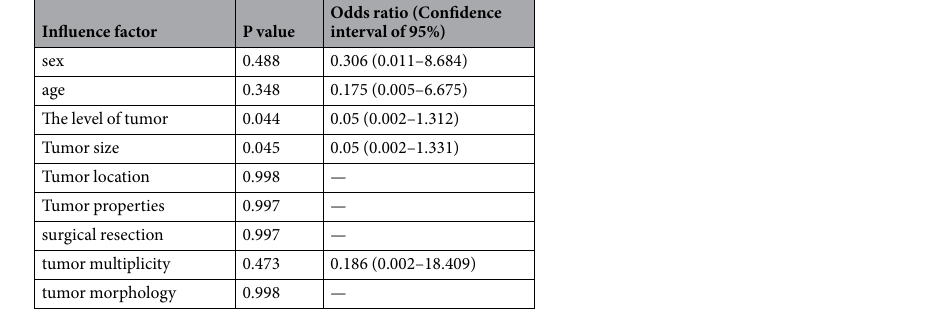
Table 5. Multivariate regression analyses of variables possibly associated with